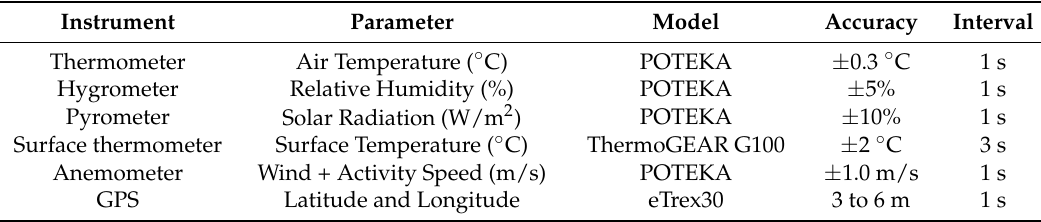
Figure 2. Vehicle and bicycle equipped with weather observation instruments. Table 1. Summary of mobile meteorological data collection. Meteorological instruments and the accuracy of each use for the mobile data collection. All were measured from an ~1.5-m height apart from the surface